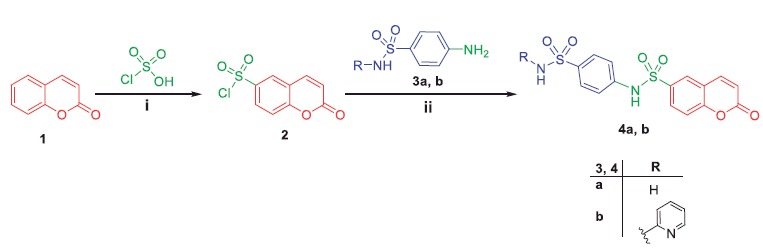
Synthesis of target compounds 4a, b; Reagents and conditions: (i) Heating 100 °C, 4 h; (ii) EtOH/reflux 12 h.